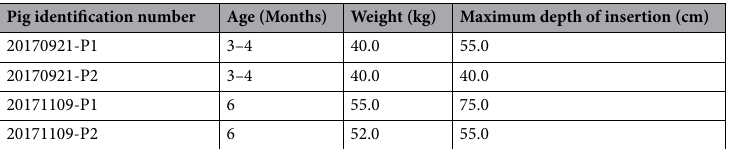
Table 4. Detailed description of the four pigs used for in vivo delivery. Age, weight and the maximum depth of insertion achieved by the capsule through the stoma are